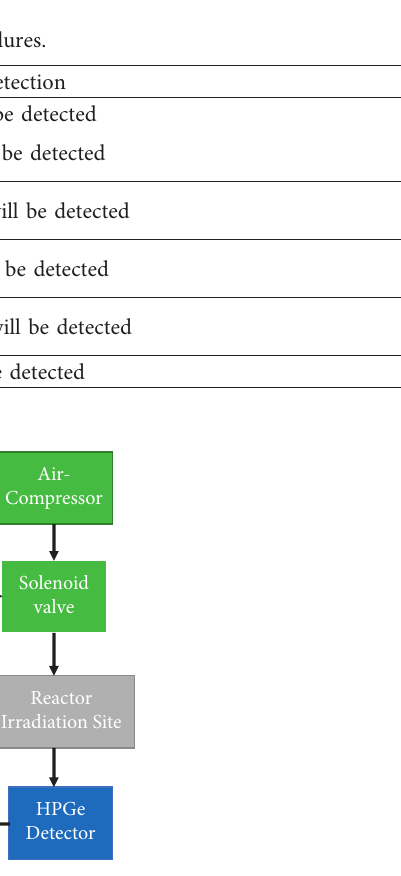
Figure 1: A complete functional block diagram of the